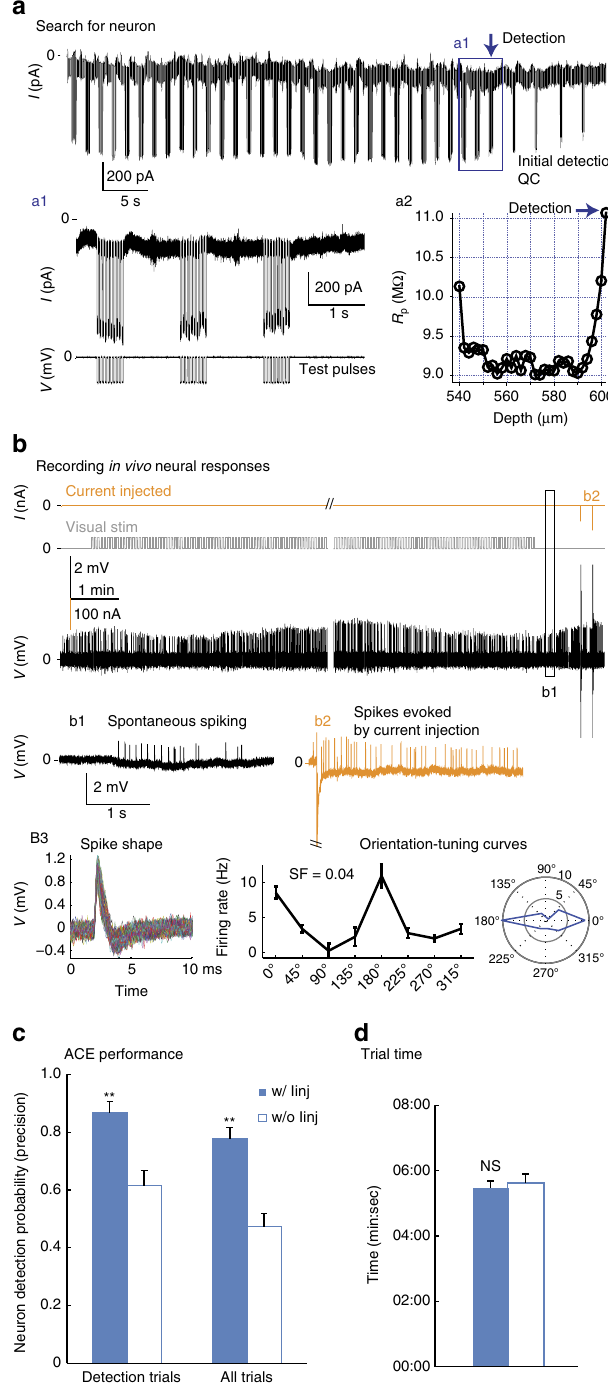
Figure 2 | ACE detects neurons efficiently with high precision and records neural activity stably in deep brain tissue. ( a ) Example current trace recorded showing automatic neuron detection by ACE in vivo . The pipette was advanced into the brain at 2 m mstep (cid:2) 1 sec (cid:2) 1 . (a1) At each step, a train of ten (cid:2) 5mV test pulses was delivered to the pipette and the current responses were measured to calculate the average pipette resistance ( R p ). R p was then compared with values calculated at previous steps to see whether the neuron detection criteria would be met. (a2) In this penetration detection occurred within 4–6 m m. A threshould of 10% R p increase was used. Initial drop of R p at 540 m m indicated a rejection event (most likely the pipette passed a dendrite or capillary). ( b ) ACE achieves stable recording. The voltage trace (high-pass filtered at 2Hz) of cell-attached recording of neural responses is shown for the same neuron detected in a . Spontaneous activity and visually evoked responses were both recorded. Orientation-tuning curve was mapped in this neuron with eight orientation, five spatial frequencies and one temporal frequency (Methods section). (b1) Normal spontaneous activity after about 18min of recording indicated no apparent damage to the cytoplasma membrane integrity. (b2) Mild current injection ( (cid:2) 100nA) evoked rapid and reversible increase of firing. Also see Fig. 4 for detection of a spontaneously inactive neuron verified by current injections. (b3) Spike shape (left) and orientation-tuning curves (middle and right) of the same neuron. Only responses to the preferred spatial frequency (0.04 cycle per degree) were shown. ( c ) Our detection–verification algorithm greatly improves the performance of neuron detections. Data were compared for detection trials in which neuron detection criteria were met (that is, the detection precision), and all trials, with or without current injection to verify the detection. ( d ) The verification by current injection had no effect on the average trial